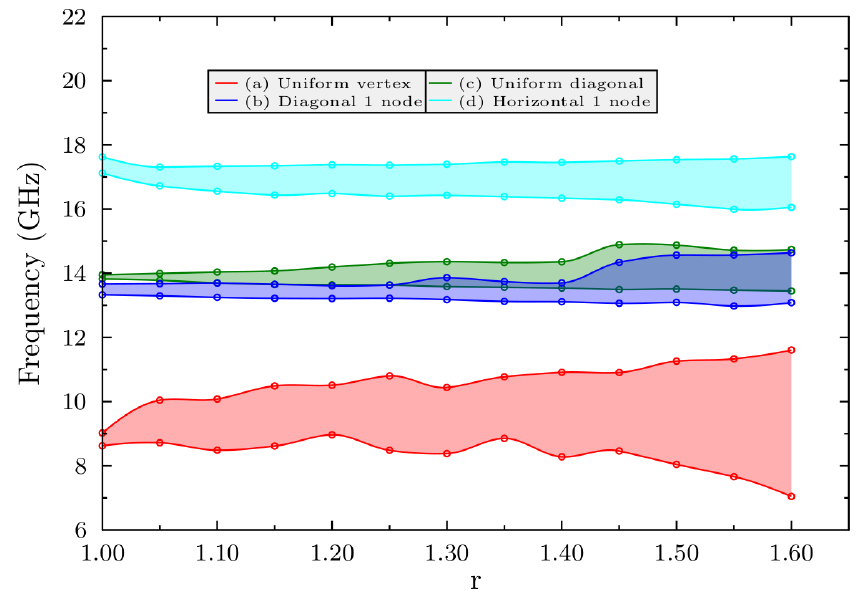
Figure 6. Frequency vs. r for some significant modes. calculated at r = 1. The modes are labeled as in Figure 4: ( a ) red: mode localized at the vertex of the hexagon base; ( b ) blue: mode with one node located on a lateral edge; ( c ) green: uniform mode (zero nodes); ( d ) cyan: mode with one node located on a